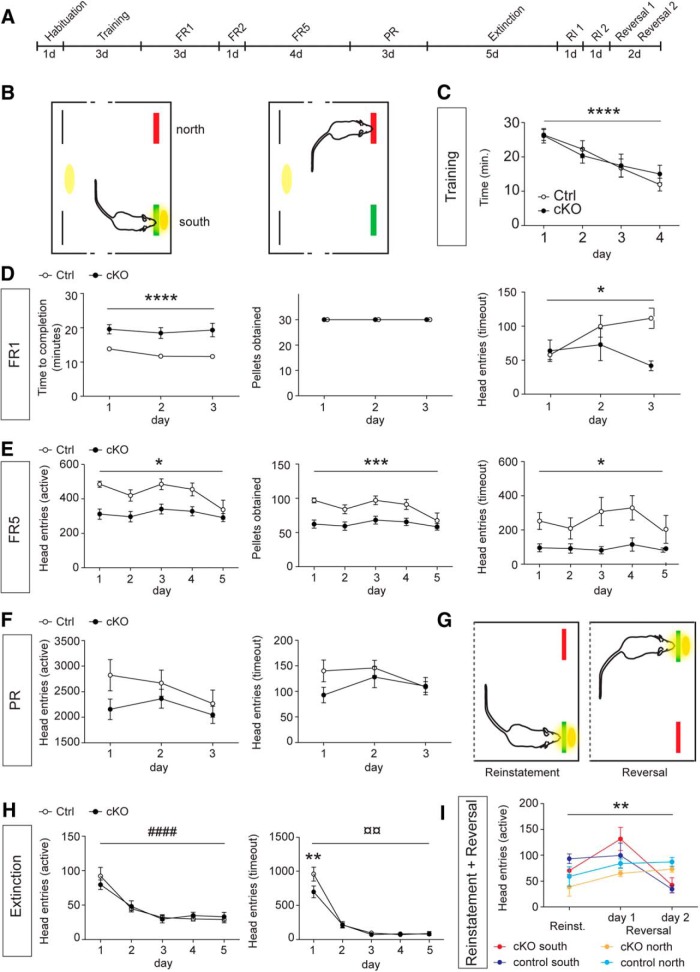
Decreased consumption of sugar in STN-VGLUT2 cKO mice. A, Schematic self-administration schedule. Black lines indicate the number of days during which each paradigm was carried out. B, Operant self-administration was carried out in modular self-administration boxes with two feeders, one of which delivered pellets upon head entry (south, green = active), and the other did not (north, red = inactive). Yellow: house light. Black bars, head entry holes measuring exploration with no feeder attached. When a mouse made a head entry at the active feeder, a sugar reward was delivered, and simultaneously, light and sound cues were presented to confirm the choice (left); a head entry at the inactive feeder produced neither reward delivery nor a light or sound cue (right). C, During task learning, both controls (white circles) and cKOs (filled circles) decreased time to obtain the maximum of 30 sugar pellets. D, During FR1, the time to consume 30 pellets was significantly higher for cKO (filled circles) compared with control (white circles; left panel). All mice were able to obtain the maximum of 30 pellets during the FR1 protocol (middle panel). The amount of head entries during the inactive time (timeout) decreased in cKO and increased in control (right). E, During FR5, head entries during active time (left), the amount of pellets obtained (middle) and head entries during inactive time (right) were lower for cKO compared with controls. F, During PR, no difference was seen in head entries during the active (left) or the inactive (timeout, right) time between control and cKO mice. G, Cognitive ability testing. During reinstatement, the mice were presented to the original task after an extinction period (left). During reversal, the positions of the active and inactive feeders were switched (right). H, To allow testing of the retention of the task (reinstatement), both cKO and control groups were put through extinction. For five consecutive days, the active feeder delivered both light and sound cues, but no sugar pellets. For both groups, the amount of head entries strongly decreased during both the active time (left) and timeout (right). I, No differences between control and cKO mice were seen during reinstatement or reversal. Statistical analysis of the self-administration data was performed using repeated-measures ANOVA followed by a post hoc test with Bonferroni correction. # or *p ≤ 0.05; ## or **p ≤ 0.01; ### or ***p ≤ 0.001, #### or **** p ≤ 0.0001. Hab., habituation; Rev., reversal; RI, reinstatement.